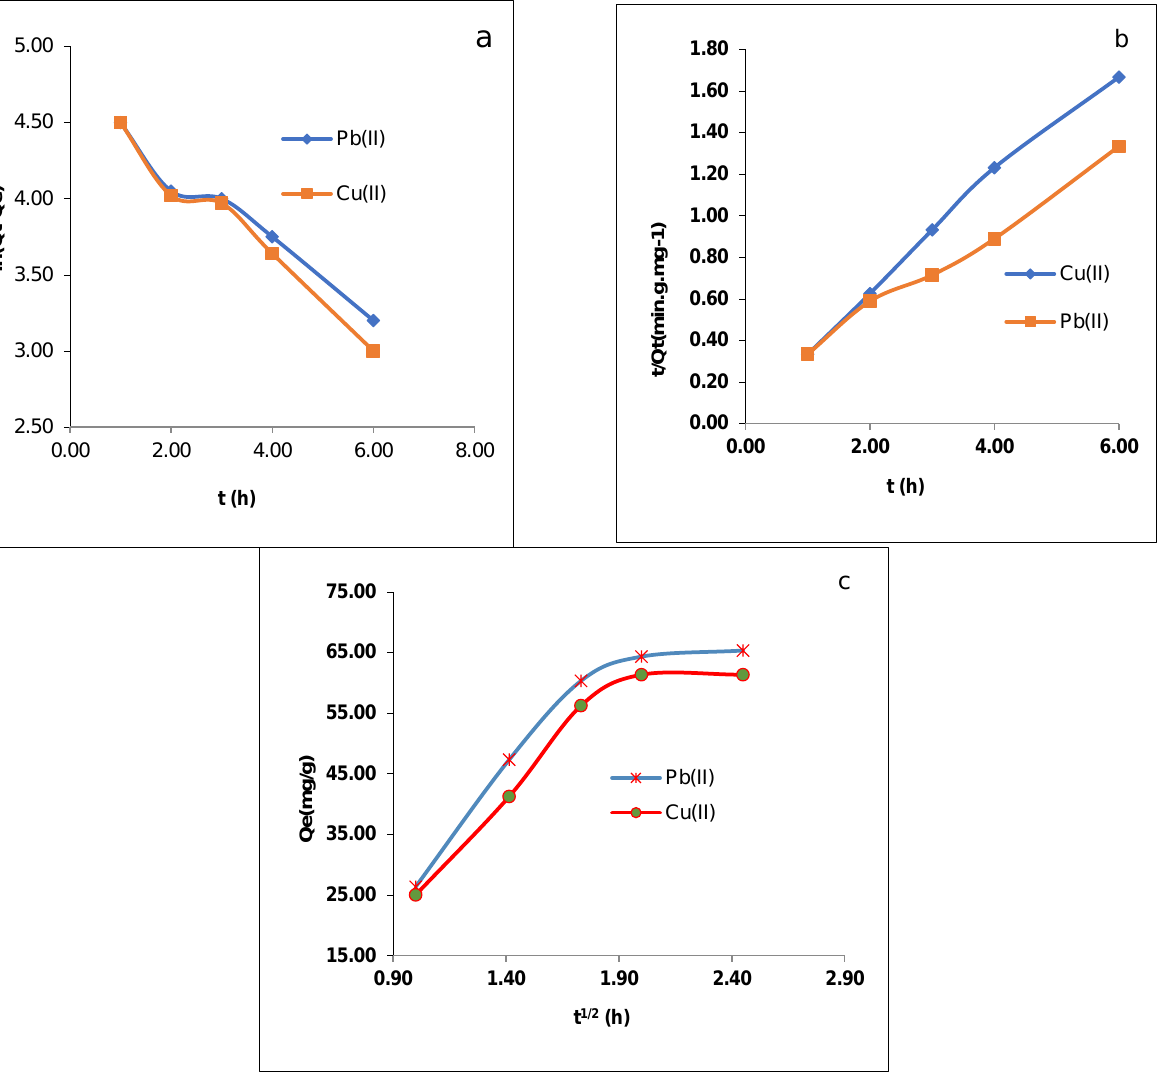
Figure 9. ( a ) Pseudo-first-order model, ( b ) pseudo-second-order model, and ( c ) intraparticle diffusion model for the Pb(II) and Cu(II) ion adsorption onto CMOISW at different concentrations. Table 3. Different kinetic model parameters for the CMOISW.